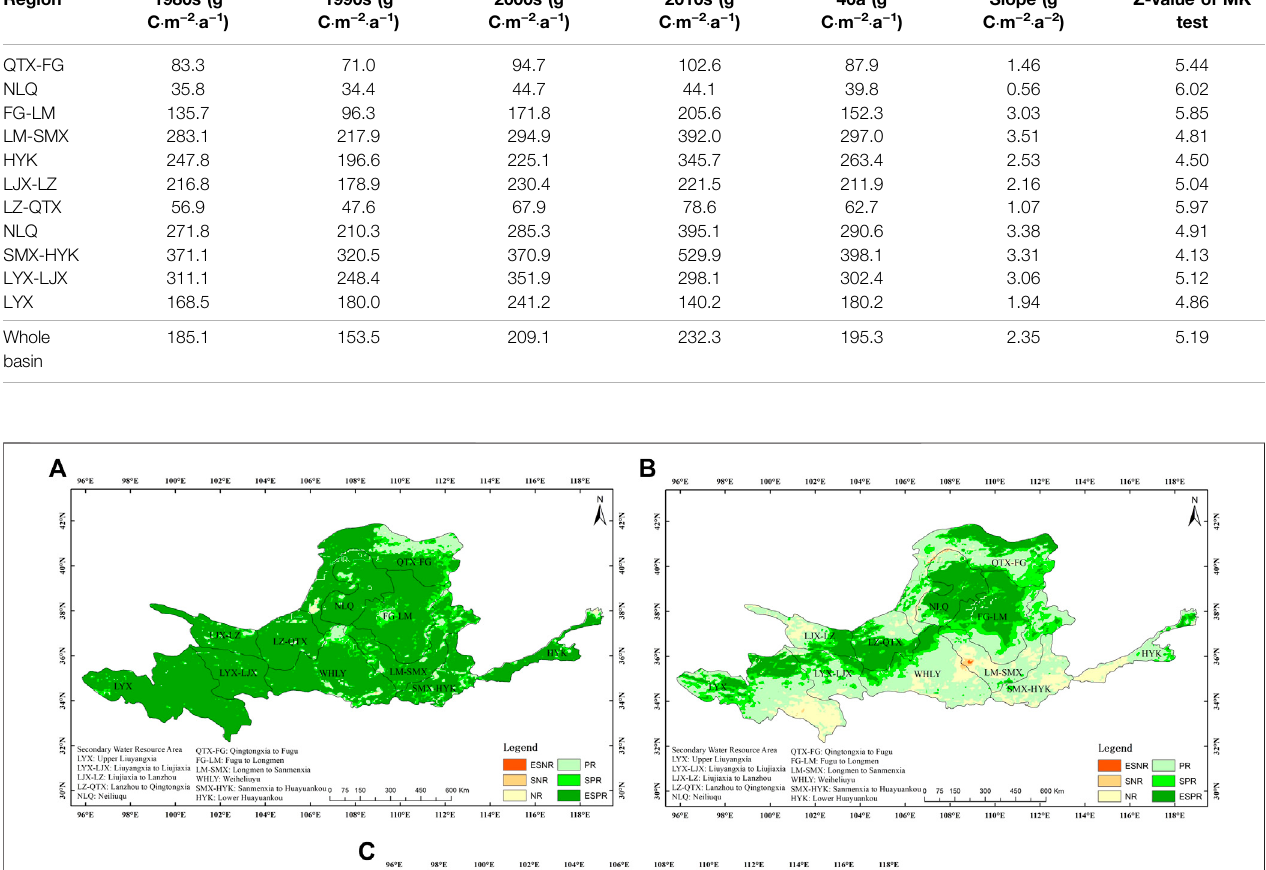
Frontiers in Environmental Science |